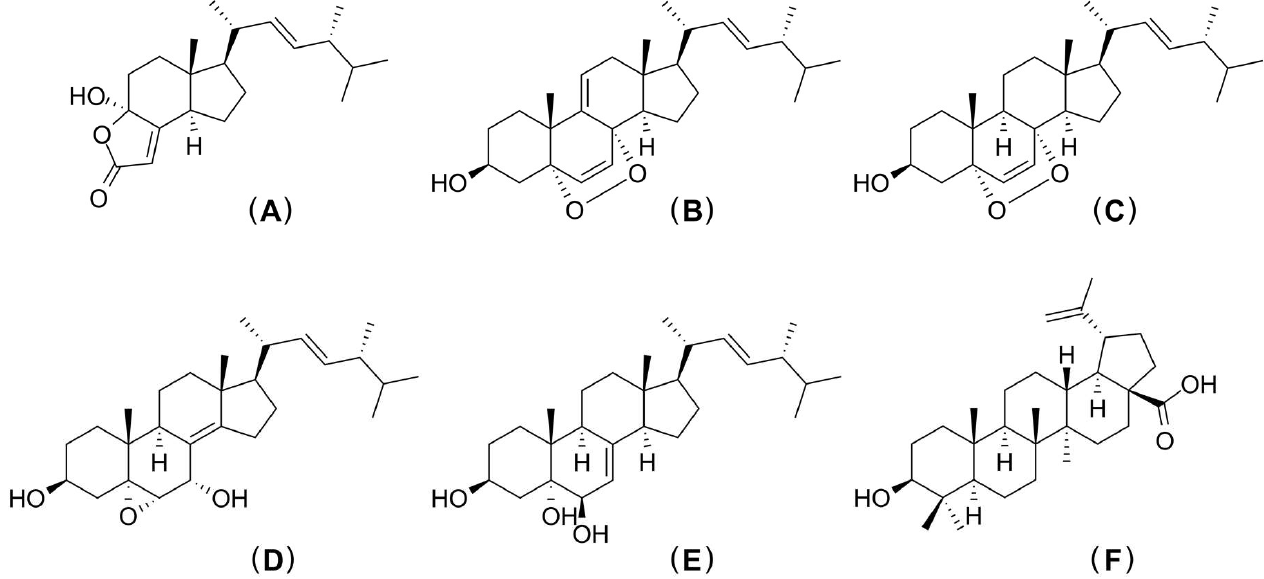
Figure 5. Anticancer compounds isolated from T. microcarpus (modified from Njue et al. [224]). Dimethylincisterol ( A ), 5 α ,8 α –epidioxy-(22 E ,24 R )-ergosta-6,9(11),22-trien-3 β -ol ( B ), 5 α ,8 α –epidioxy-(22 E ,24 R )-ergosta-6,22-dien-3 β -ol ( C ), 5 α ,6 α -epoxy-(22 E ,24 R )-ergosta-8(14),22-diene-3 β ,7 α -diol ( D ), (22 E ,24 R )-ergosta-7,22-diene-3 β ,5 α ,6 β -triol ( E ) and betulinic acid ( F ).